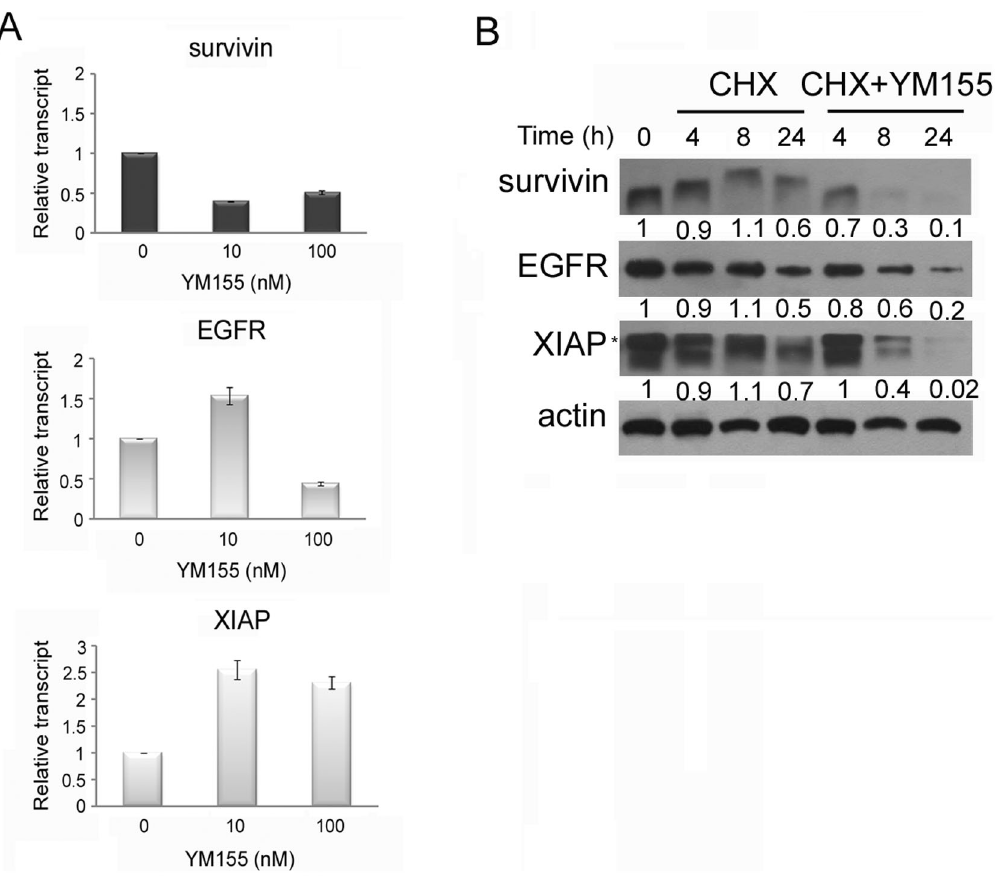
Figure 4. YM155 increases the degradation of survivin, EGFR, and XIAP in PANC-1 cells. A, After treatment of PANC-1 cells with YM155 for 24 hours, survivin, EGFR, and XIAP mRNA levels were determined using real-time RT-PCR. B, Survivin, EGFR, and XIAP levels in PANC-1 cells after treatment with 50 m g/ml cycloheximide (CHX) in the absence or presence of 100 nM YM155 for the indicated periods were examined by Western blotting. The ratio of survivin, EGFR, or XIAP:actin expression compared with the control is shown for each lane. *,